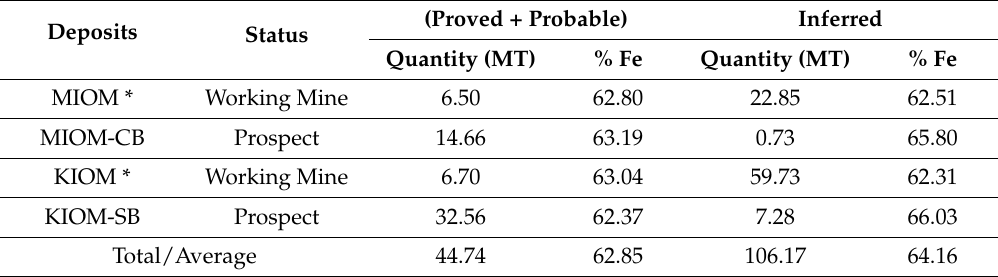
Table 1. Resources of High-grade Iron Ores at Kiriburu-Meghahatuburu iron ore deposit (KMIOD) comprising of Meghahatuburu Iron Ore Mine (MIOM); Kiriburu Iron Ore Mine (KIOM); Central Block (CB); South Block (SB); Source: Mining Plan Division, Steel Authority of India Limited,